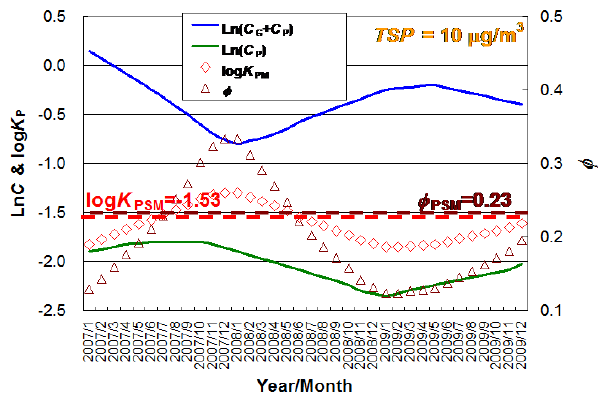
Figure 5. The temporal trends of concentrations of BDE-209 in the Arctic air in gas and particle phases (blue line) and in particle phase (green line) at Alert, Canada from 2007 to 2009 (NCP 2013). The purple triangles and red diamonds are the values of ϕ and log K P of BDE-209, respectively, calculated using the concentration data, and match well the values of φ PSM ( = 0.23) and log K PSM ( − 1.53), respectively (TSP = 10µgm − 3 was